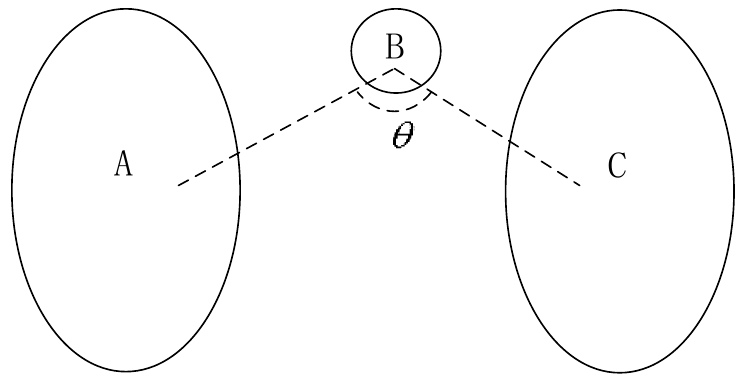
Figure 4. Illustration of the definition “between” in [1].